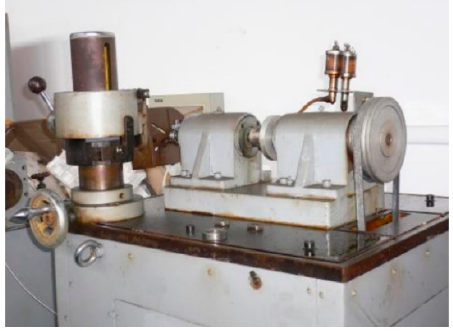
Figure 2. The test rig.